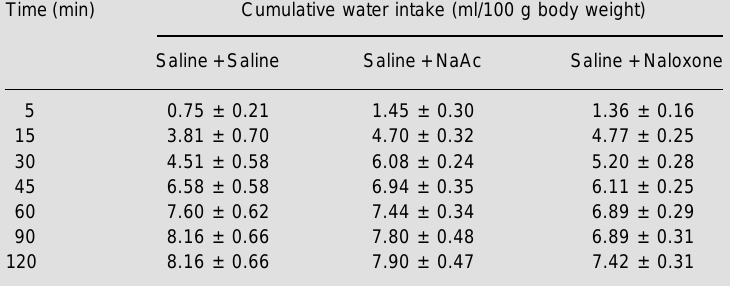
Table 1 - Effect of treatment with saline, NaAc and naloxone (82.5 nmol/rat) on water intake (ml/100 g body weight) in dehydrated animals free of heavy metals pretreated with saline. Data are reported as mean ± SEM for 10 animals in each group. Statistical analysis (repeated measures ANOVA followed by the Scheffé test) showed no difference among